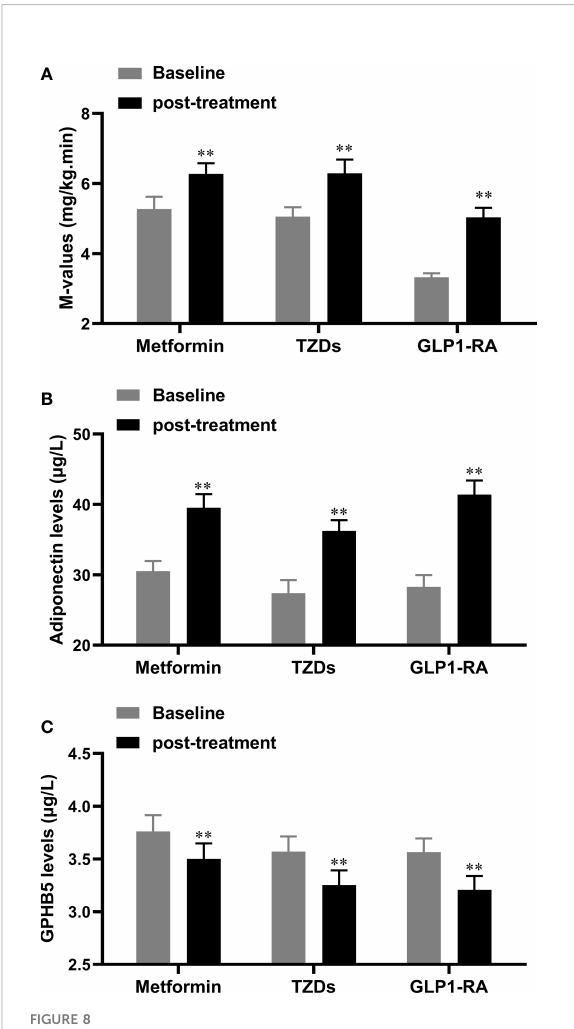
FIGURE 8 Serum GPHB5 and adiponectin levels in PCOS patients before and after treatment. (A) the changes of M-values during the EHC before and after treatment. (B) Circulating adiponectin levels before and after treatment. (C) Circulating GPHB5 levels before and after treatment. Data are means ± SD. * p <0.05, ** p< 0.01 vs.